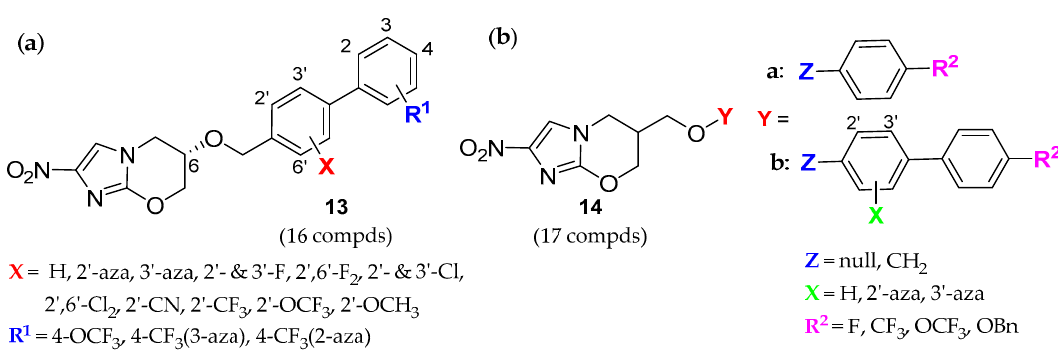
Figure 8. ( a ) biaryl -OCH 2 - ( 13 ) and ( b ) -CH 2 O- ( 14a , b ) analogues to study effects on oxidative metabolism.